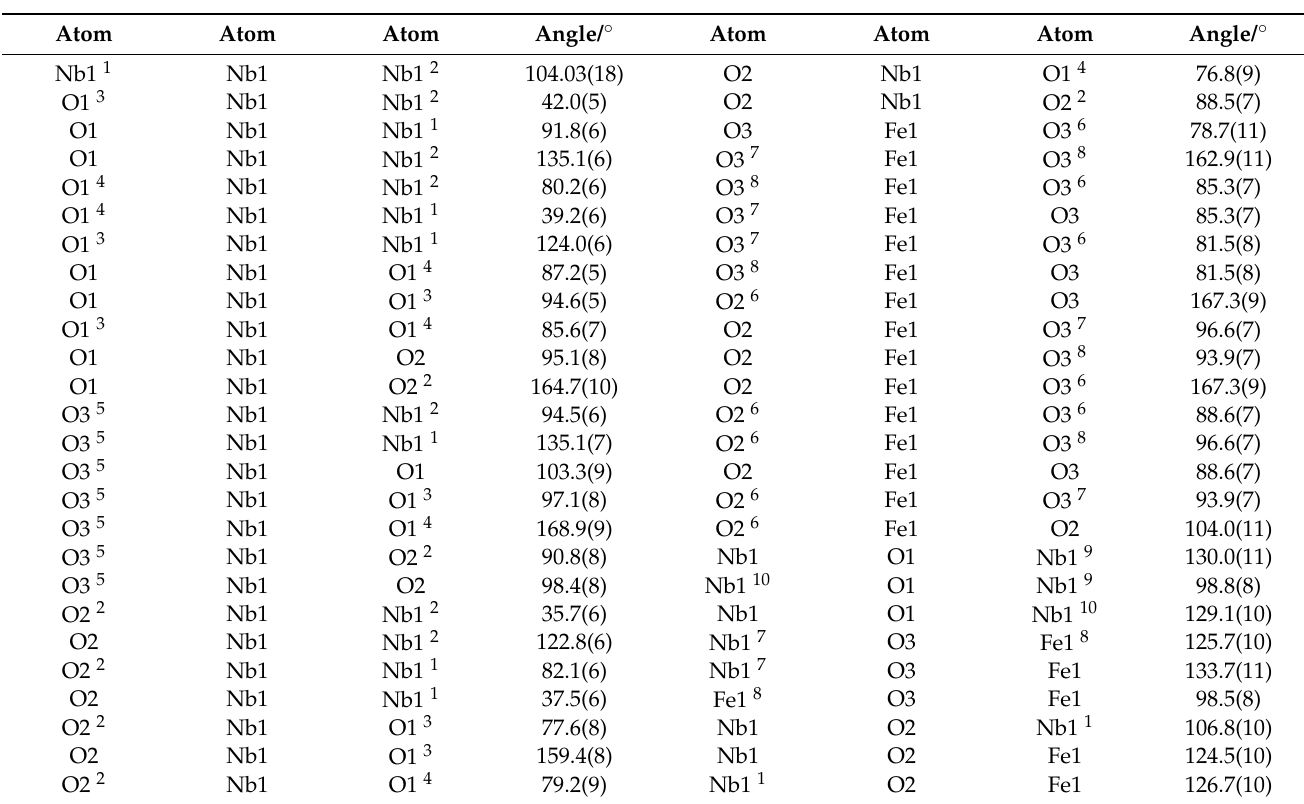
Table A5. Bond angles for